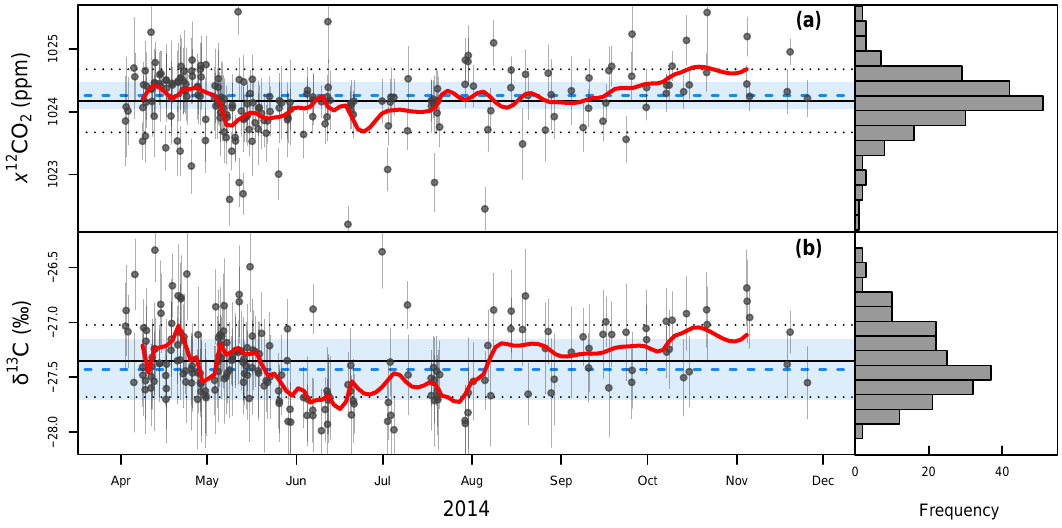
Figure 6. Repeated syringe sample measurements in (a) x 12 CO 2 and (b) δ 13 C–CO 2 of standard gas NA2 (Table 1) over a 9-month period ( n = 200). Error bars denote ± 1 intrasample SD of each individual measurement. Grand means are the solid black horizontal lines with dotted lines indicating ± 1SD of all measurements. Ten sample moving averages are shown in red. Histogram insets on the right depict cumulative distributions of syringe measurements. Blue dashed lines indicate the direct bottle measurement of NA2 with blue-shaded areas covering ± 1SD of the bottle